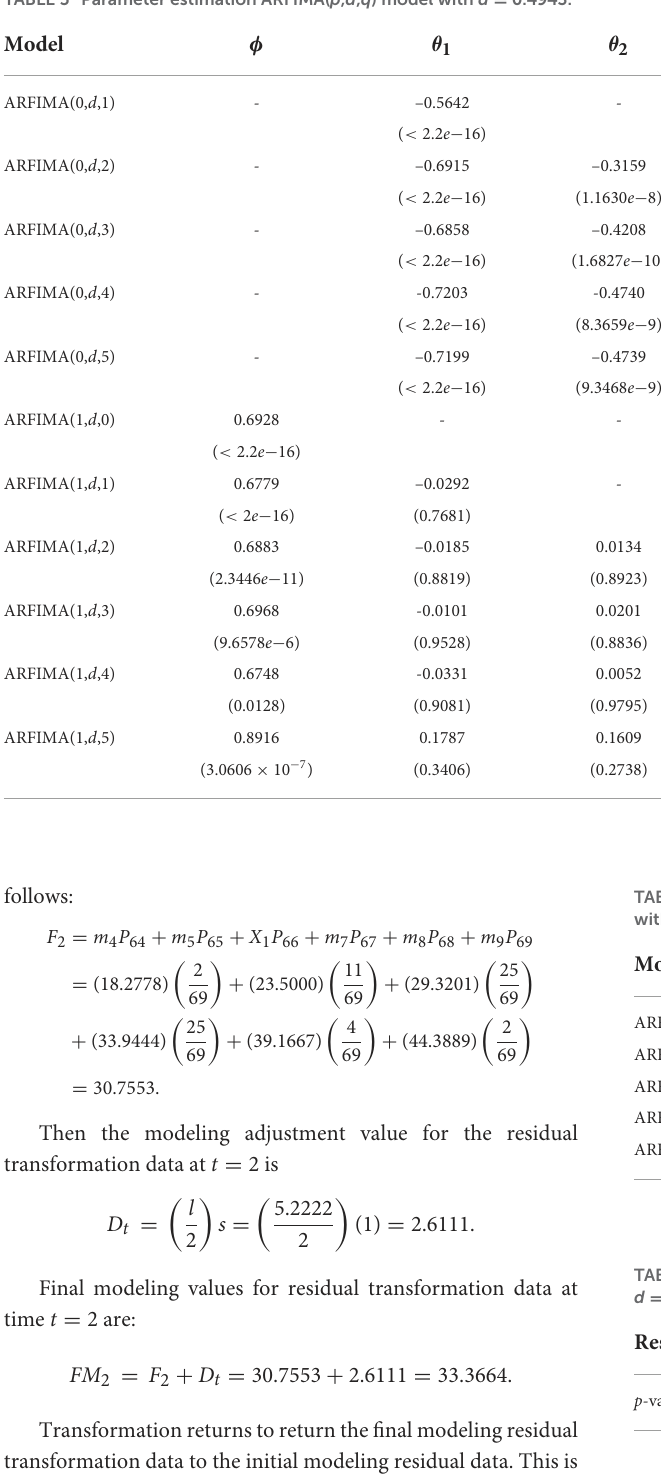
TABLE 5 Parameter estimation ARFIMA( p , d , q ) model with d = 0.4943.